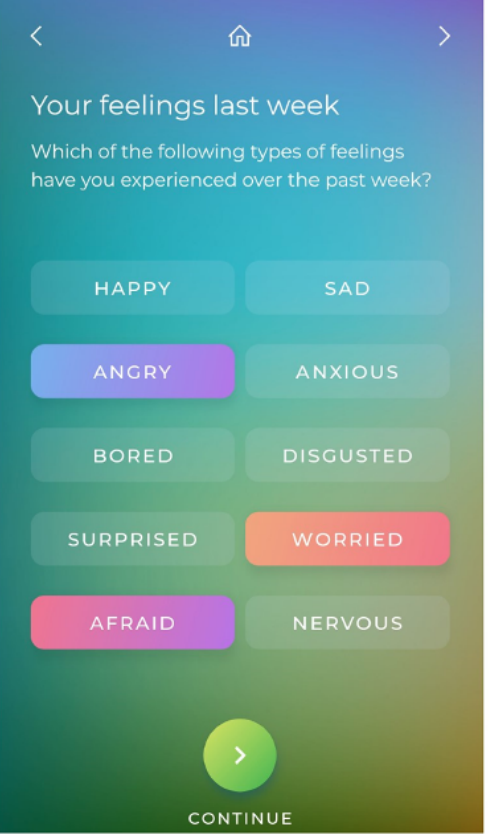
Figure 3. Screenshots of the Identifying Emotions exercise from Module 1 of the Whitu: 7 Ways in 7 Days app.